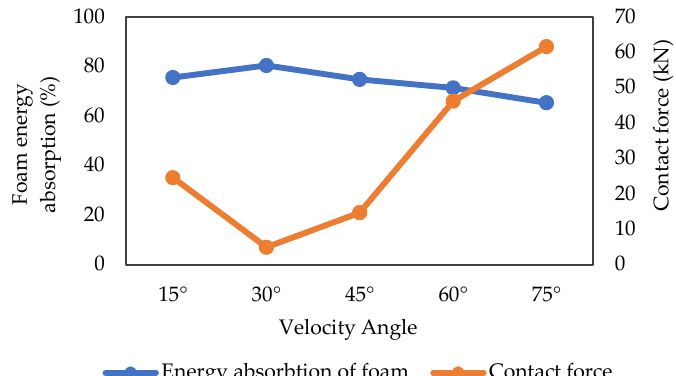
Figure 19. Energy absorption and contact force from simulation at 27 kph for case III.